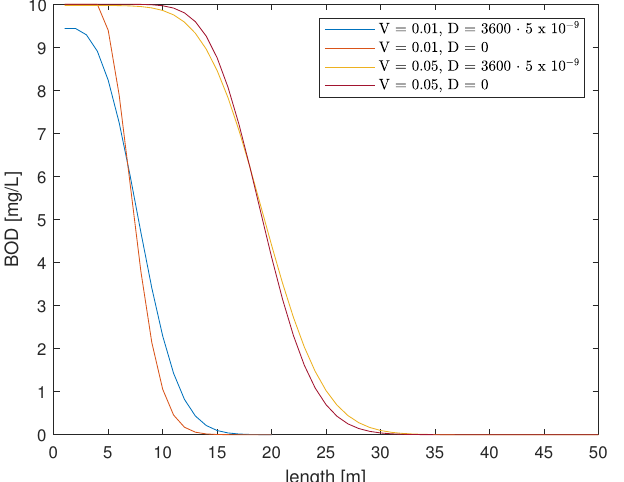
Figure 19. BOD distribution for different velocities, excluding diffusion ( D = 0 ) and including diffusion ( D > 0 ) .